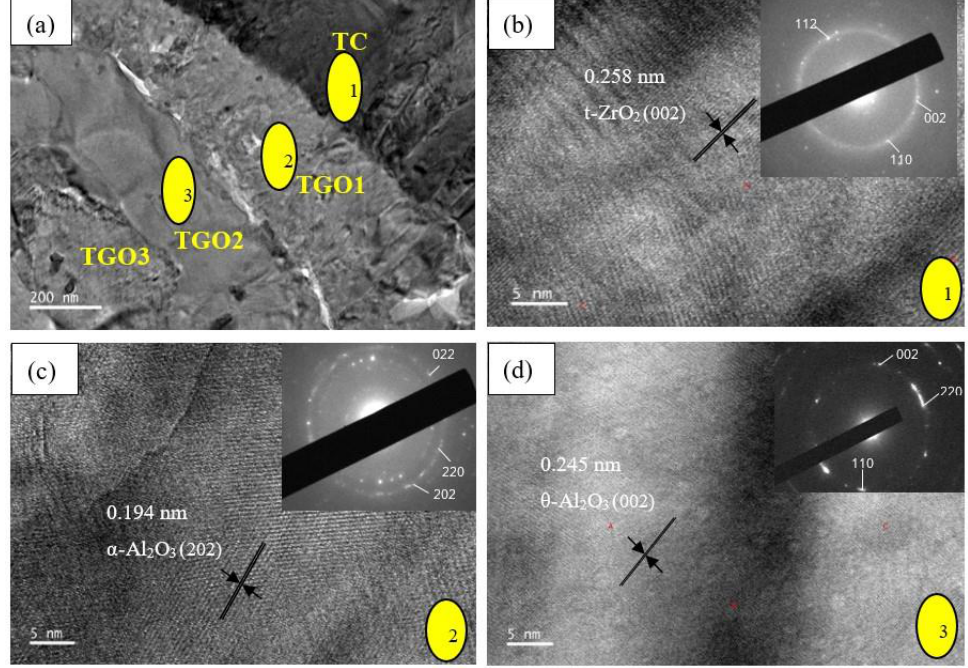
Figure 12. TEM micrograph of ( a ) TGO cross-sectional of sample H100h with interplanar distance and diffraction patterns at ( b ) topcoat, ( c ) TGO1, and ( d ) TGO2.